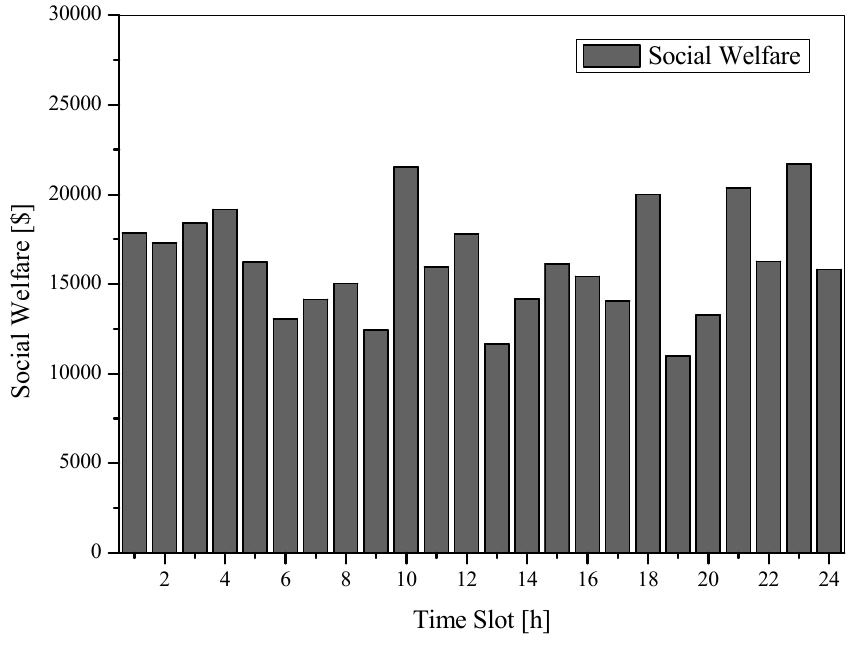
Figure 5. Social welfare of each time slot.